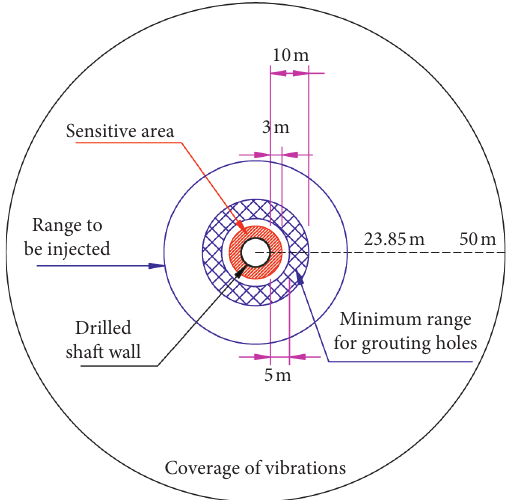
Figure 5: Relationship between the grouting range and coverage of